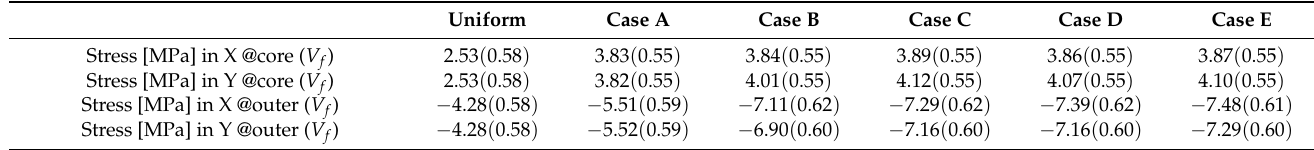
Table 5. Average stress and V f values in the core (tensile) and the outer regions (compressive). Uniform Case A Case B Case C Case D Case